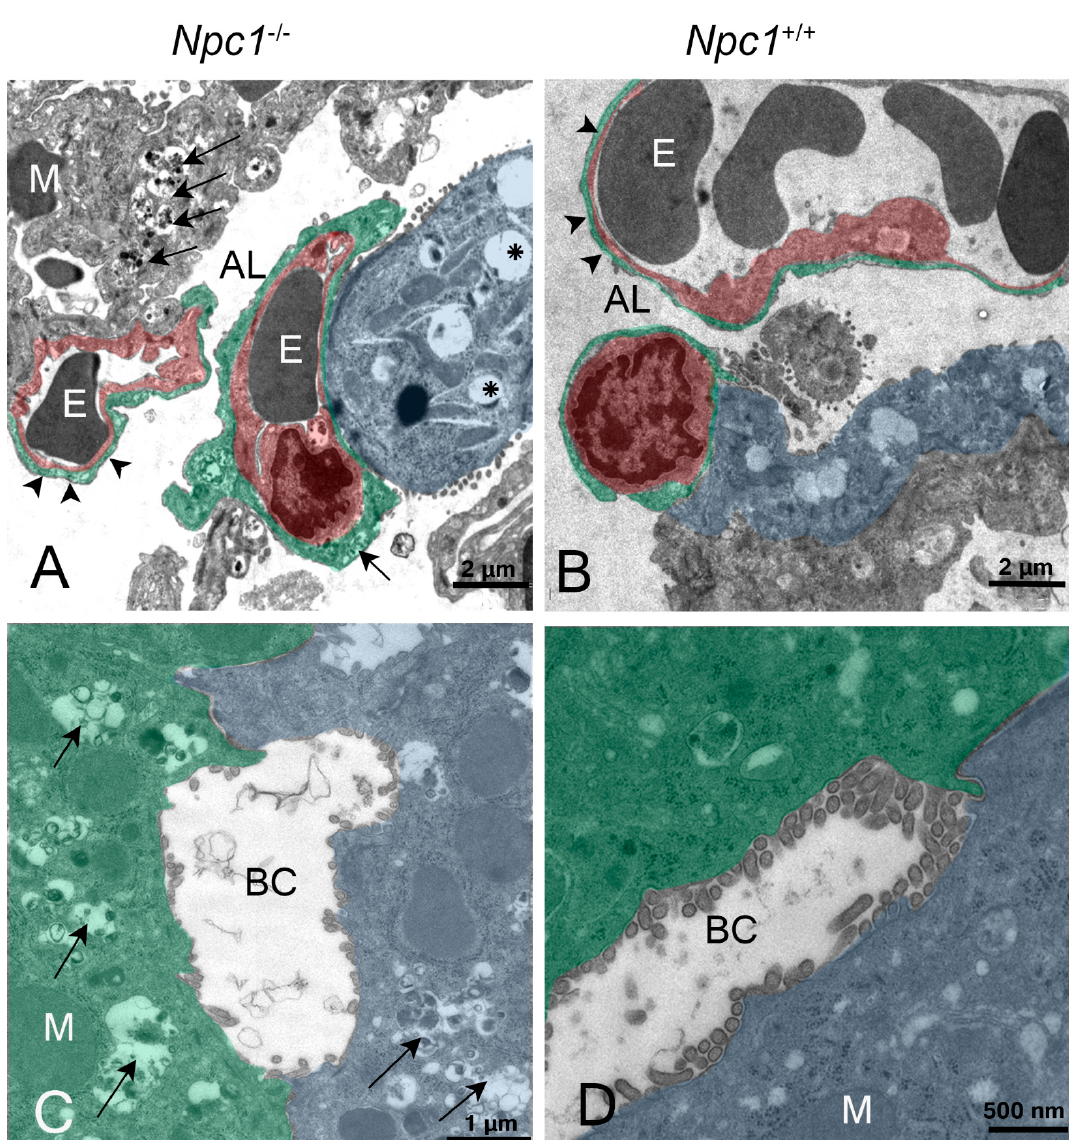
Figure 17. Transmission electron micrographs of the lung ( A , B ) and liver ( C , D ) of male Npc1 − / − ( A , C ) and Npc1 +/+ ( B , D ) mice. ( A ) Myelin-like inclusions (arrows) occur in endothelial cells (colored in red), enlarged portions of type I pneumocytes (green, arrowheads) of the blood-air barrier, and macrophages (M). Type II pneumocytes (blue) often contain large secretory vesicles (*) void of lipophilic substances such as a surfactant. Al, alveolar space; E, erythrocyte. ( B ) Alveolar substructures in a wild-type mouse do not contain pathologic lipophilic deposits. ( C ) Two adjacent hepatocytes (green and blue, respectively) form a biliary capillary ( B , C ) with multiple lipophilic inclusions (arrows) of late Golgi stacks/lysosomes. ( D ) Similar aspect of two hepatocytes in a wild-type mouse with normal morphology. M, mitochondrion; BC, bile capillary.